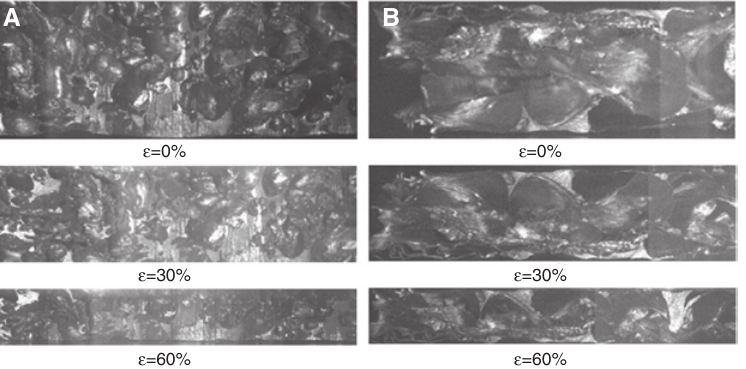
Figure 8 Images captured from deformation of the (A) NSC and (B) NLC foams at 0%, 30%, and 60% compressive strains.